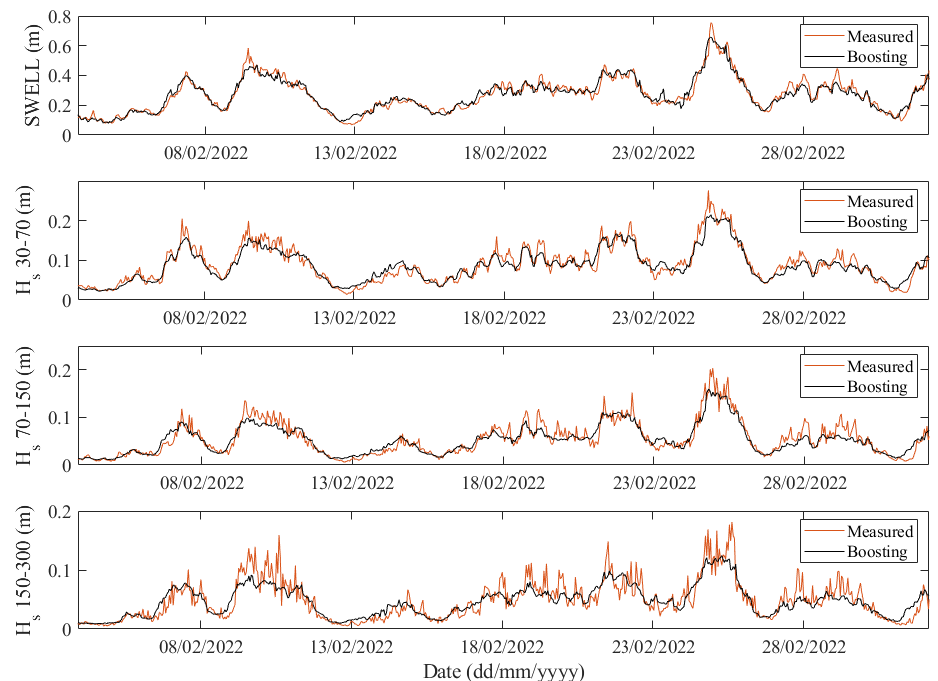
Figure 8. Measured and predicted data with the formula and with GBM of the H s in sensor S4 for the different frequency ranges.